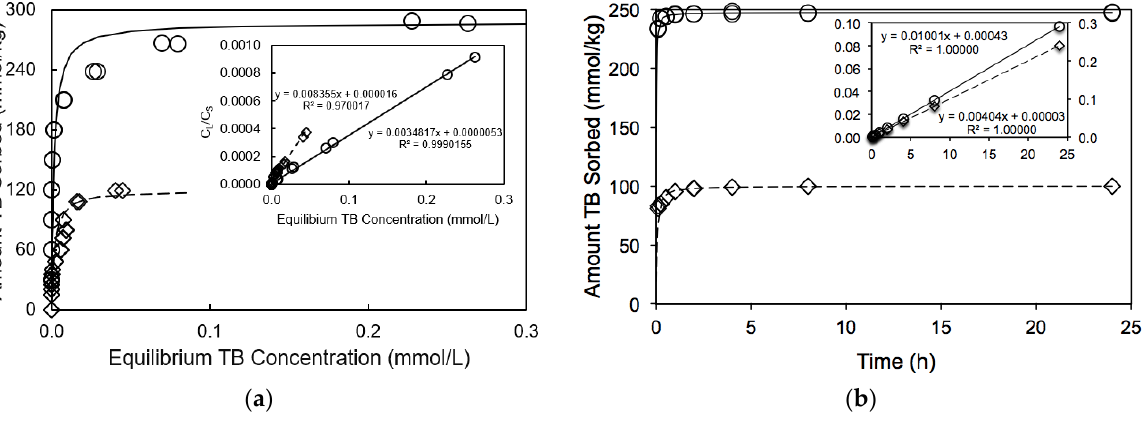
Figure 2. Isotherm ( a ) and kinetic study of TB sorption on PAL and SEP. The lines are Langmuir ( a ) and pseudo-second order ( b ) fits to the experimental data. The inset is the fit to their linearized form.